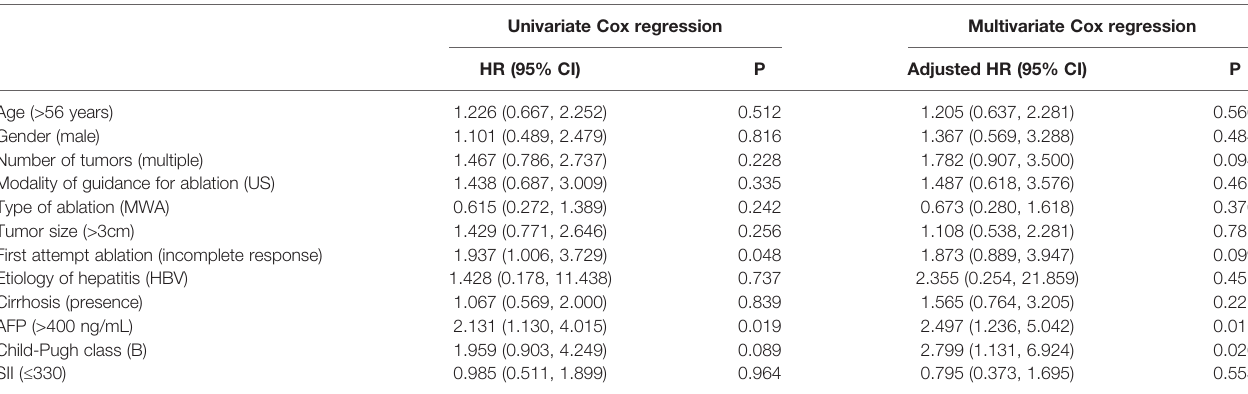
TABLE 4 | Univariate and multivariate Cox regression analysis for